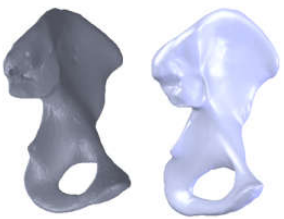
Figure 25. Left iliac bone model (two views with different viewing options).